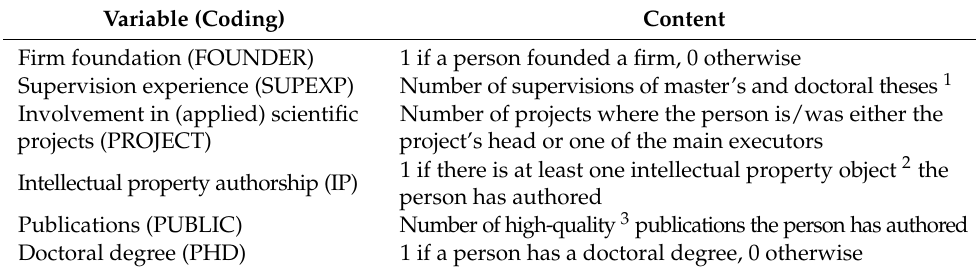
Table 1. Variables used in the